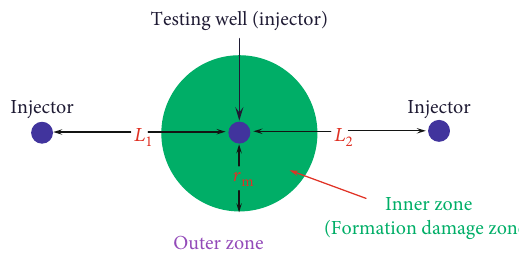
Figure 3: Schematic of the physical model. The green is the inner zone (formation damage zone), indicating the formation damage area. The orange is the outer zone, where permeability remains unchanged. r is the radius of the inner region in the schematic. m and L denote the well spacing between the testing well and L 1 2 each adjacent injector.